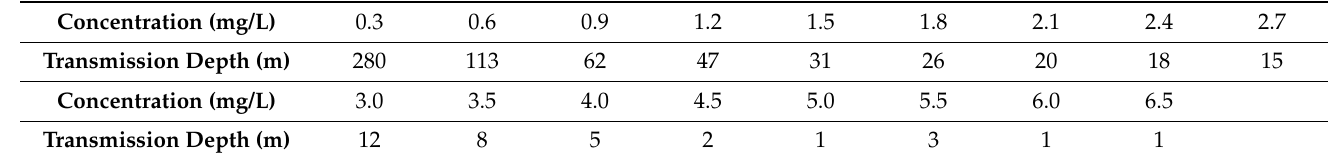
Table 2. Maximum transmission depths in seawater containing different suspended matter concentrations.